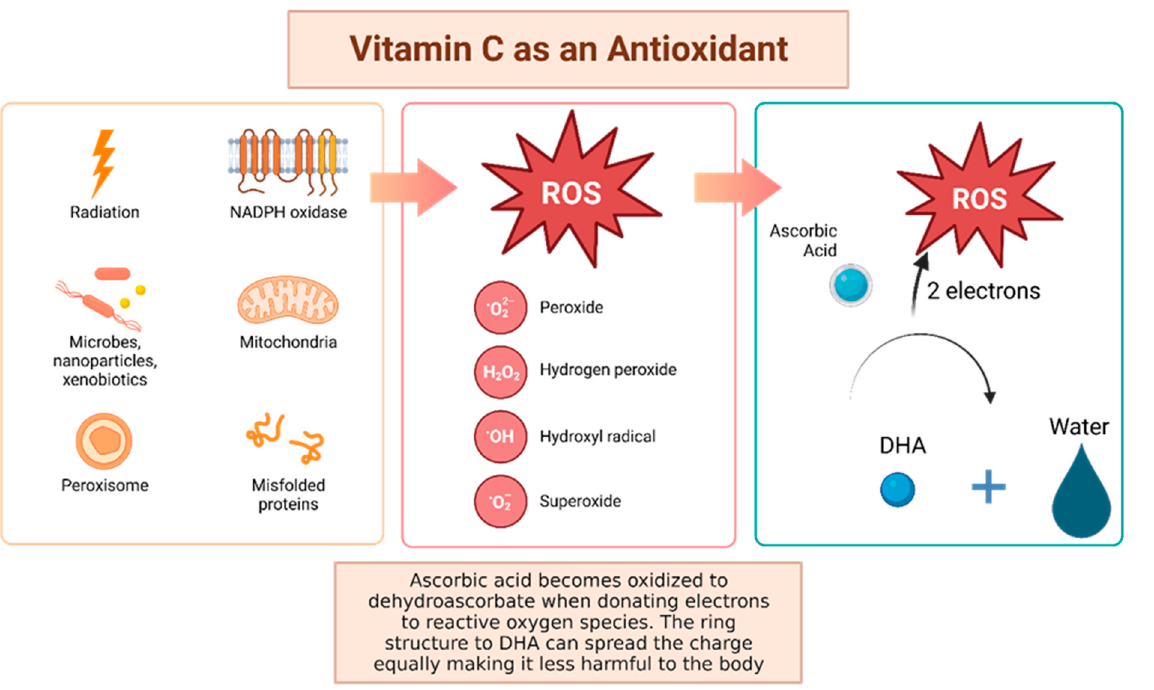
Figure 4. Vitamin C has been shown to have antioxidant properties, allowing it to reduce free radicals that may cause harmful damage to DNA. Reactive oxygen species (ROS) may be made by peroxisomes, radiation, the mitochondria, and more biological processes which result in ROS. Vitamin C acid, when ingested, contains electrons that it can give to reactive oxygen species. These will be reduced to water, and therefore will not be harmful to the body [92]. The oxidized version of vitamin C, or dehydroascorbate, has the ability to even out the positive charge with its ring structure ensuring that it, itself, is not going to damage cells